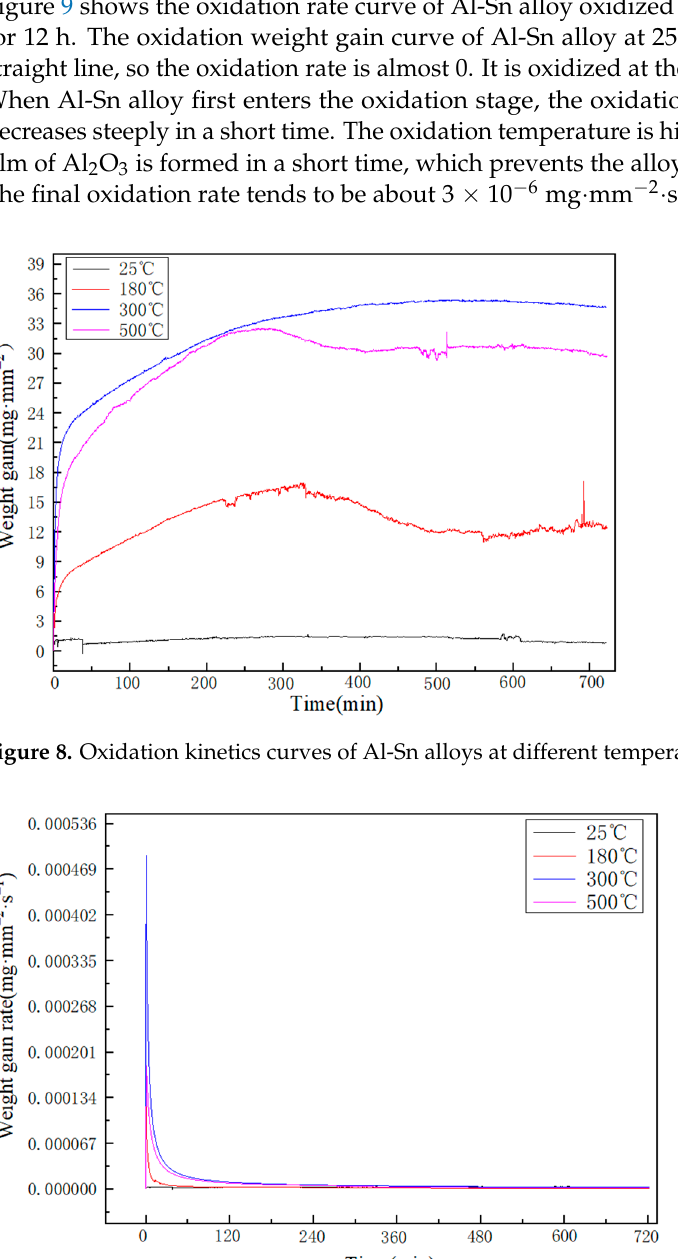
Table 3. Fitting equations of the oxidation rate curves of the Al-Sn alloy.